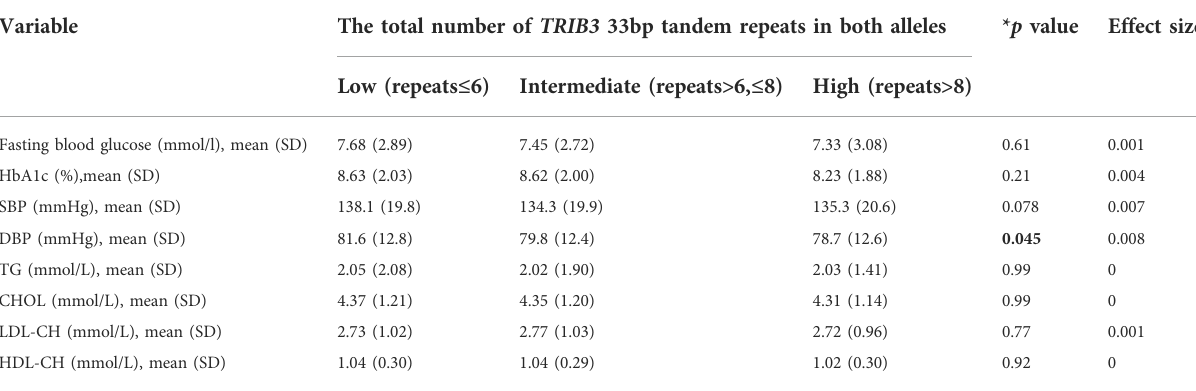
TABLE 3 Relationship between TRIB3 promoter 33 bp VNTR and blood pressure, lipids and glucose in T2DM patients.